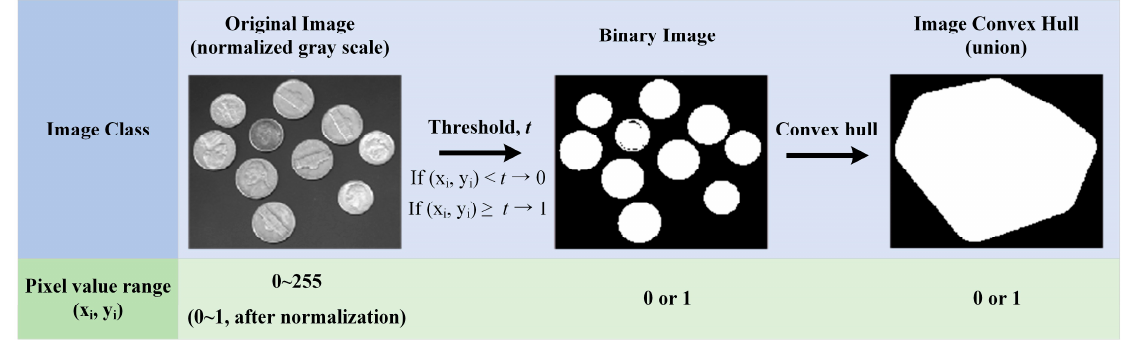
Figure 3. Description of image convex hull.